Question: Is the quantity shown trending increasing or decreasing?
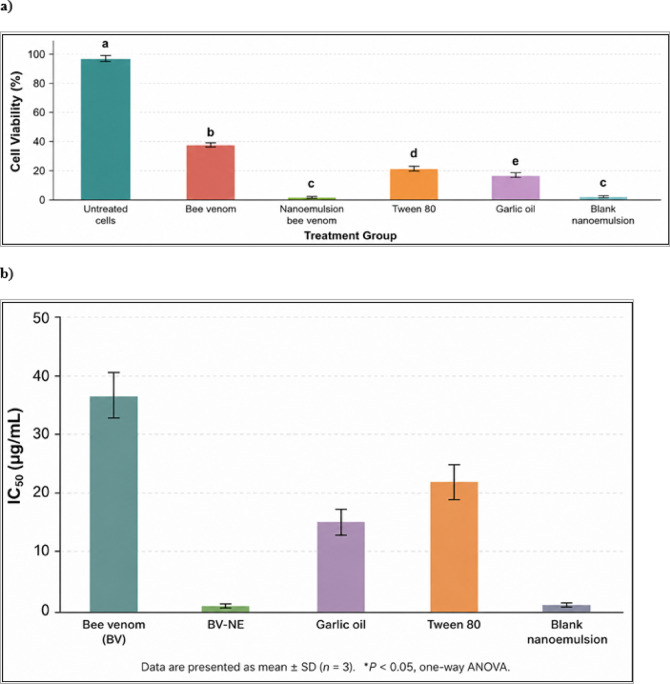
Answer: increasing